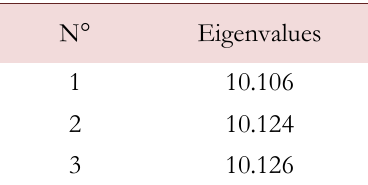
Table 9: Buckling load eigenvalues.